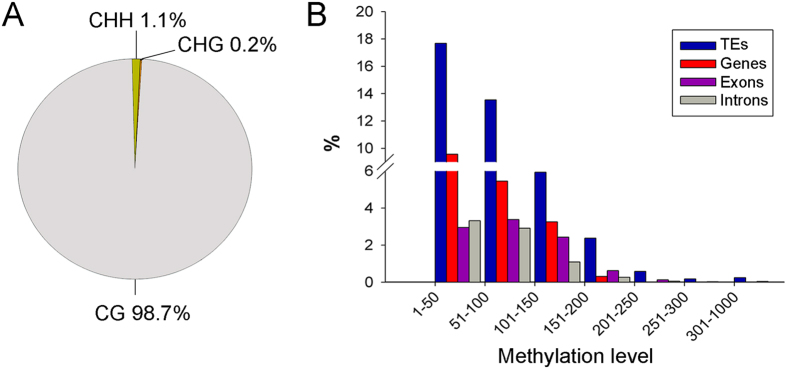
The characteristics of cytosine methylation.A) Characteristics of the dinucleotide and trinucleotide contexts of the methylation loci. B) Comparison of the methylation levels among the TEs, genes, exons and introns.